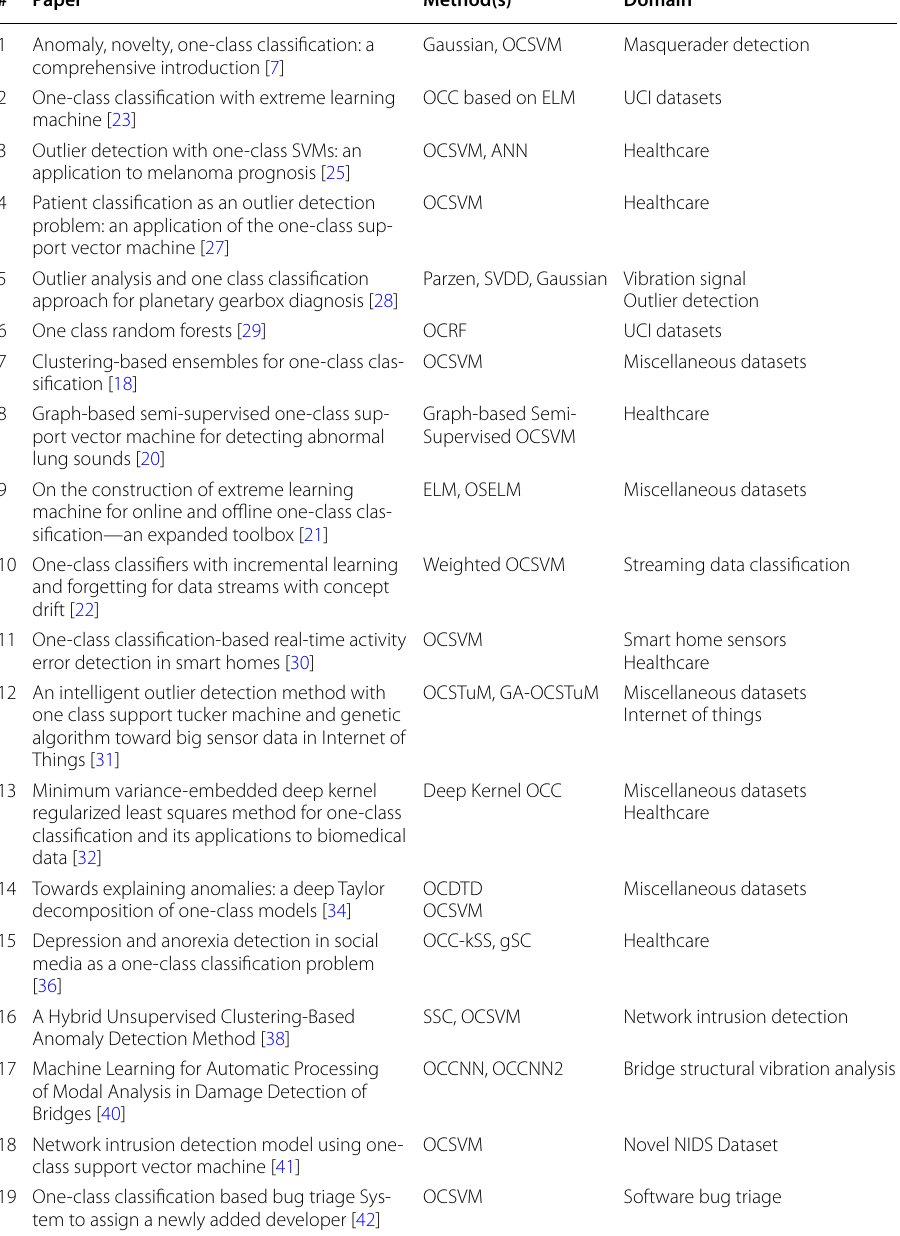
Table 1 Surveyed works on outlier detection and